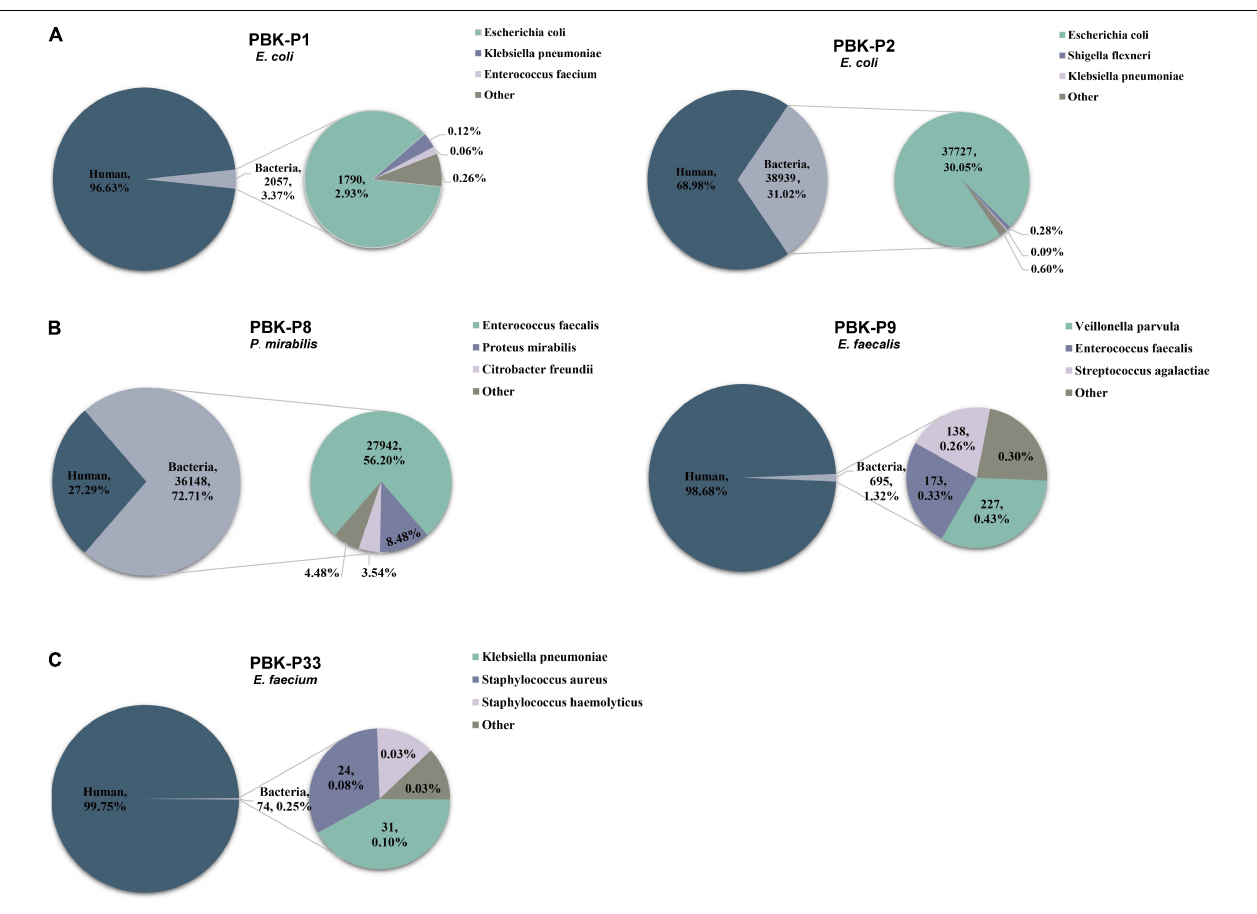
FIGURE 3 | Pie charts demonstrating the taxonomic classification of reads for three different situations and showing the top 3 bacteria with percentage distributions of sequencing reads. Different colors indicate different species, the title indicates the method of library preparation, sample ID, and culture-based result. (A) Examples had one obviously dominant bacterial taxon. (B) Examples had two or more apparently predominant bacterial strains. (C) Examples with no obvious dominant bacteria and relatively few bacterial